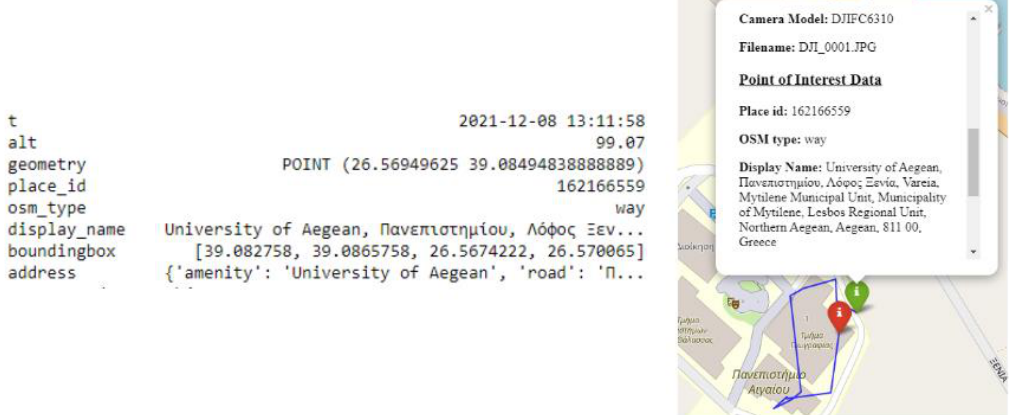
Figure 10. Point of interest data obtained using open Web services.